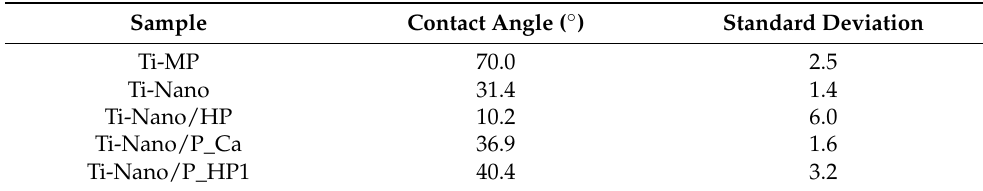
Table 3. Contact angles of water on Ti-MP, Ti_Nano, Ti-Nano/HP, Ti-Nano/P_Ca, and Ti- Nano/P_HP1.